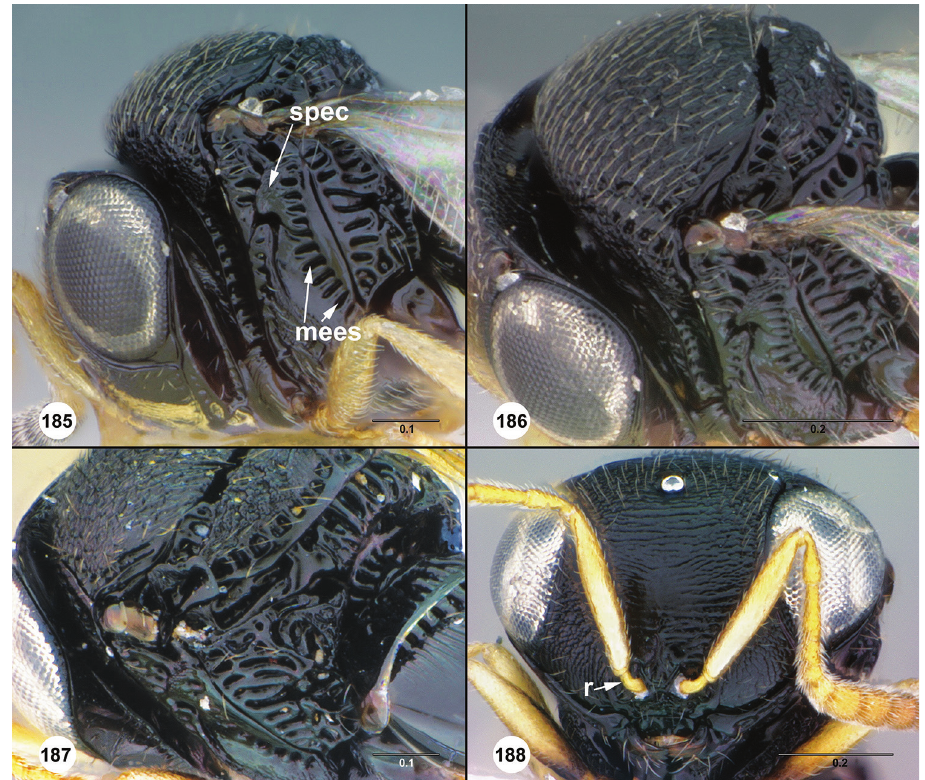
Figures 185–188. Trissolcus stoicus 185 female holotype (B.M. TYPE HYM. 9.314), head and meso- soma, lateral view 186 female holotype (B.M. TYPE HYM. 9.314), head and mesosoma, dorsolateral view 187 female (OSUC 285262), mesosoma, posterolateral view 188 female (OSUC 285262), head, anterior view. Scale bars in